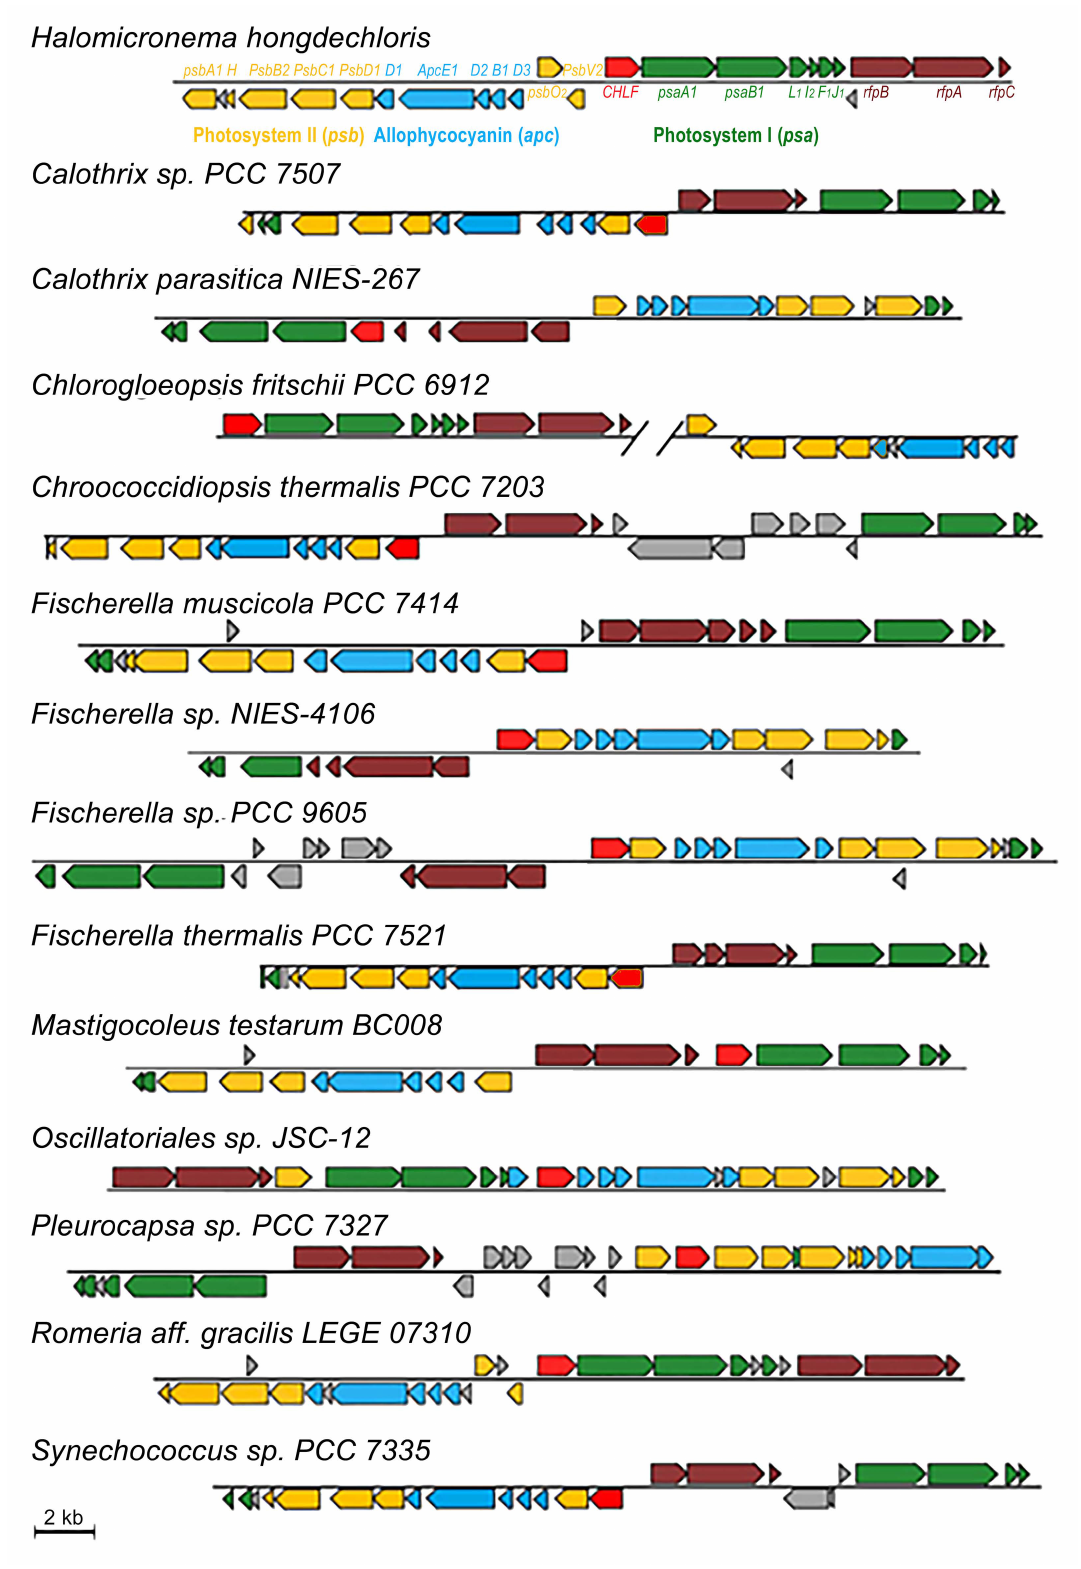
Figure 4. FaRLiP gene clusters from 14 CA6-capable cyanobacteria. The identities of the genes from H. hongdechloris are used as references. Blue represents the Allophycocyanin (Apc) subunits; green represents genes encoding photosystem I ( psa ); yellow represents genes encoding photosystem II ( psb ); red represents Chl f synthase (CHLF) homolog; dark-red represents the Rfp operons ( rfp ABC); gray represents hypothetical